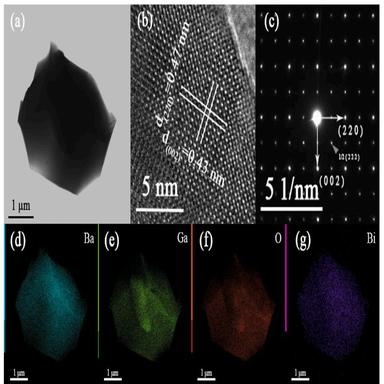
(a) TEM image, (b) HR-TEM image, (c) SAED pattern, (d–g) element distribution of BGO:0.005Bi3+ sample.